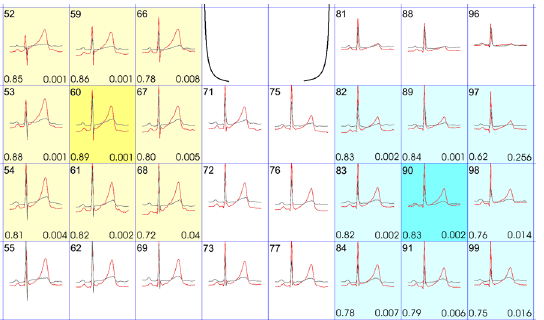
Fig 3. Superimposition of two typical BSM recordings from the region of interest: Red curves from a patient with LQT2 and without clinical event, black curves from a patient with LQT2 and with clinical event. Region of interest for T-wave integral is yellow highlighted, region of interest for T-wave amplitude range is blue highlighted. Channel numbers are listed on the left top of each rectangle, Area under curve values from ROC analysis are listed on the left bottom and P values of ROC analysis are listed on the right bottom of each rectangle